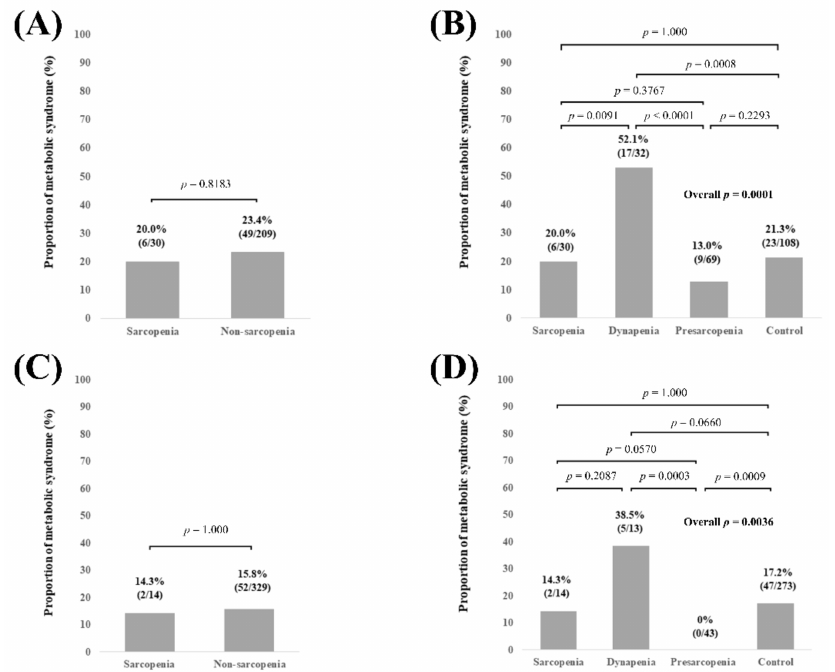
Figure 4. ( A ) Proportion of Met-S in patients with sarcopenia and non-sarcopenia in patients aged 65 years or more (n = 239). ( B ) Proportion of Met-S in patients with sarcopenia, dynapenia, presarcopenia, and control in patients aged 65 years or more. ( C ) Proportion of Met-S in patients with sarcopenia and non-sarcopenia in patients less than 65 years (n = 343). ( D ) Proportion of Met-S in patients with sarcopenia, dynapenia, presarcopenia, and control in patients less than 65